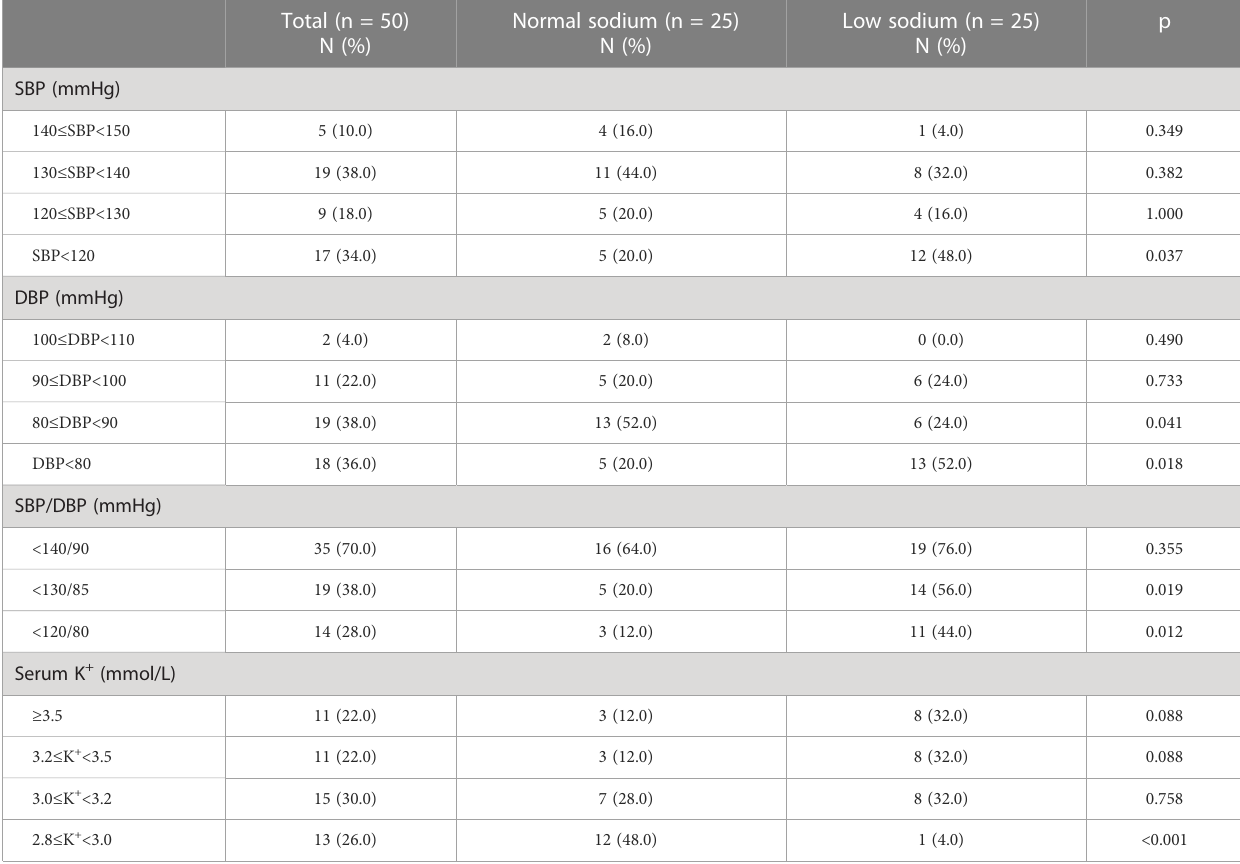
TABLE 3 Control rates for serum potassium and blood pressure after the dietary